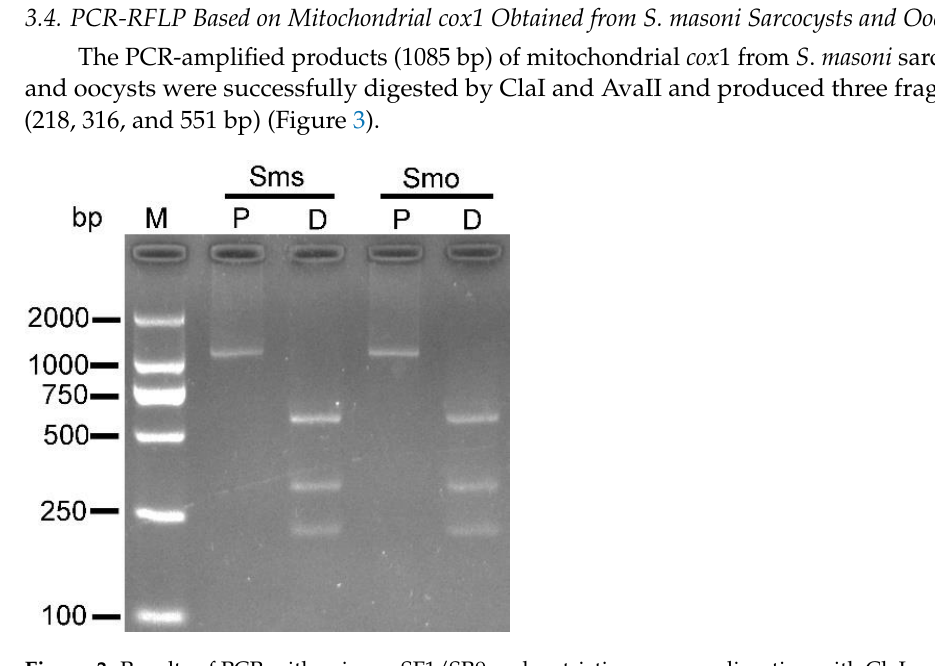
Figure 4. Phylogenetic trees of selected Sarcocystis species. The trees constructed based on ( a ) 18S rDNA sequences, ( b ) 28S rDNA sequences, and ( c ) mitochondrial cox 1 sequences using maximum likelihood (ML) with the Tamura 3-parameter, Hasegawa – Kishino – Yano, and Kimura 2-parameter models, respectively. The values between the branches represent bootstrap values per 1000 repli- cates, and values below 50% are not shown. ( a ) The six newly obtained 1 8S rDNA sequences of S .